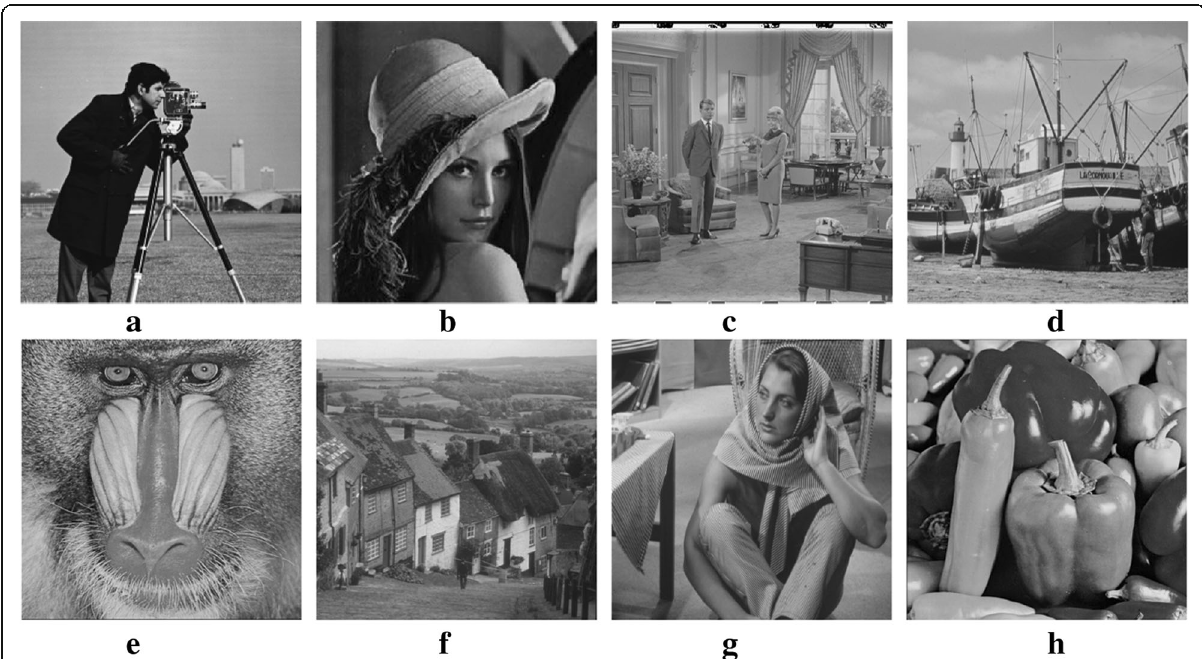
Fig. 5 a Cameraman. b Lena. c Couple. d Boats. e Baboon. f Town. g Barb. h Peppers